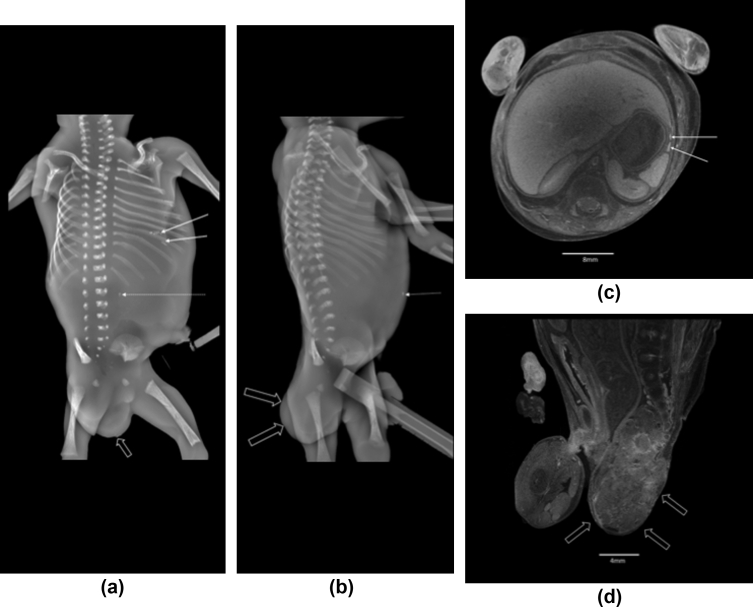
A 16-week gestational aged fetus with sacro-coccygeal teratoma. The frontal (a) and lateral (b) PMSS radiographs reveal left upper quadrant calcification (solid white arrow) and a midline focus of calcification (dotted arrow), the latter felt to represent artefact on surface of fetal body. The large soft-tissue mass representing the teratoma (open, unfilled arrow) does not contain any internal calcification on PMSS. At subsequent micro-CT, acquired at 75 μm resolution (c), the left upper quadrant calcification was intra-peritoneal. A sagittal section of the pelvis on micro-CT, acquired at 18 μm resolution (d) demonstrates the presacral mass. There was no internal calcification, the high density within the lesion represents pooling of contrast media.